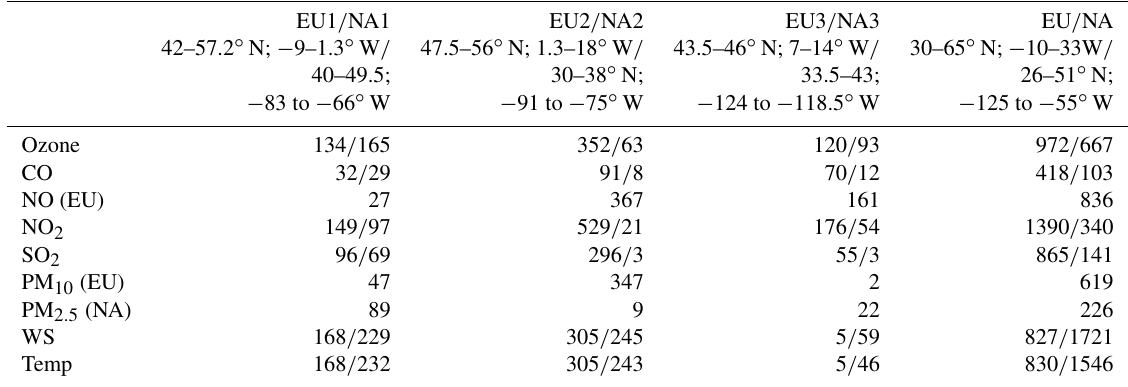
Table 3. Extension of the subregions and number of receptors used in the